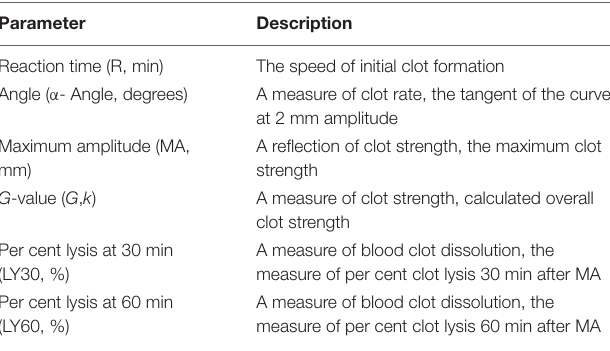
TABLE 1 | Description of thromboelastography (TEG)